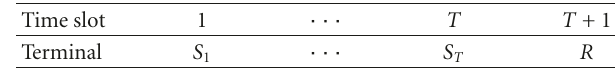
Table 1: Half-duplex transmission